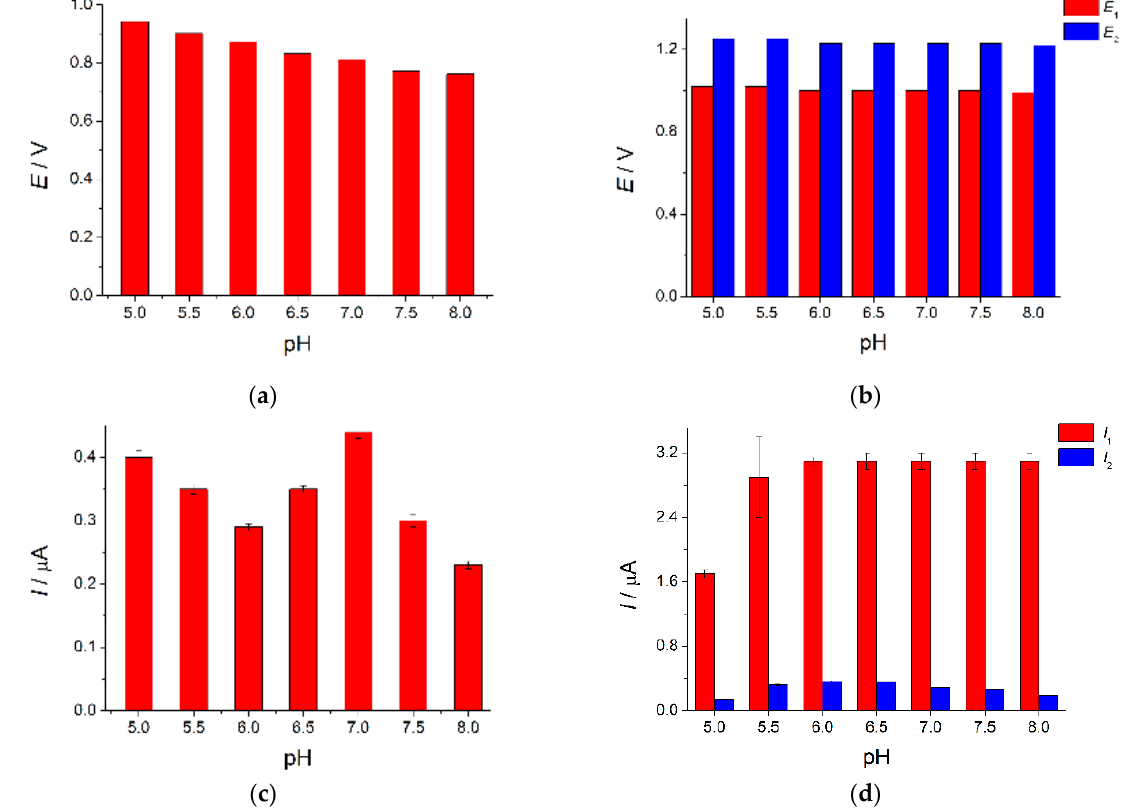
Figure 7. Effect of phosphate buffer pH on the voltammetric characteristics of dyes on the MnO 2 nanorods-modified electrode: ( a ) oxidation potential of 10 μM tartrazine; ( b ) oxidation potentials of nanorods-modified electrode: ( a ) oxidation potential of 10 µ M tartrazine; ( b ) oxidation potentials of 100 μM brilliant blue FCF; ( c ) oxidation currents of 10 μM tartrazine; ( d ) oxidation currents of 100 100 µ M brilliant blue FCF; ( c ) oxidation currents of 10 µ M tartrazine; ( d ) oxidation currents of 100 µ M μM brilliant blue FCF. brilliant blue